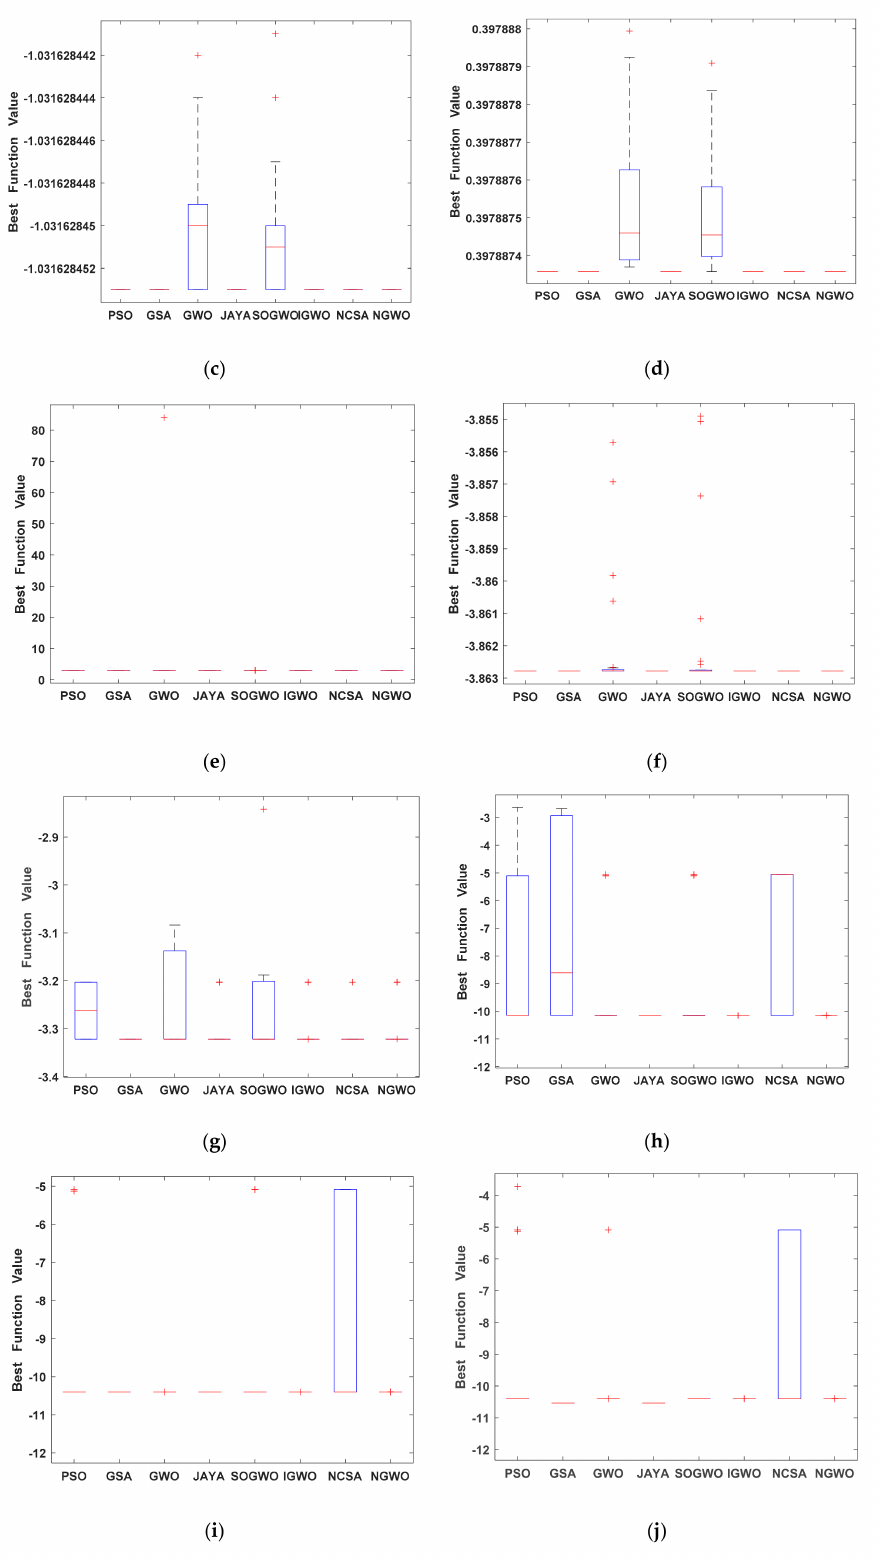
Figure 7. Box plot of the fixed dimensional multi-modal benchmark functions (F 14 –F 23 ). Here, ( a ) represents benchmark function F 14 , ( b ) represents benchmark function F 15 , ( c ) represents benchmark function F 16 , ( d ) represents benchmark function F 17 , ( e ) represents benchmark function F 18 , ( f ) represents benchmark function F 19 , ( g ) represents benchmark function F 20 , ( h ) represents benchmark function F 21 , ( i ) represents benchmark function F 22 , ( j ) represents benchmark function F 23